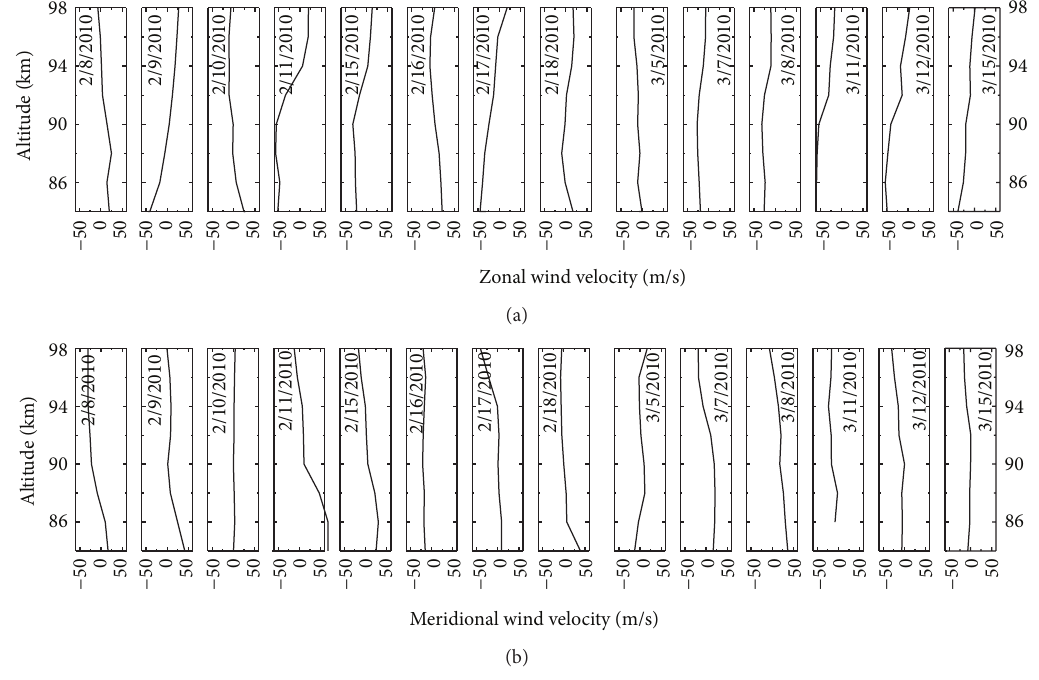
Figure 4: Observed mean zonal (a) and meridional (b) wind variability corresponding to the night airglow observations during February and